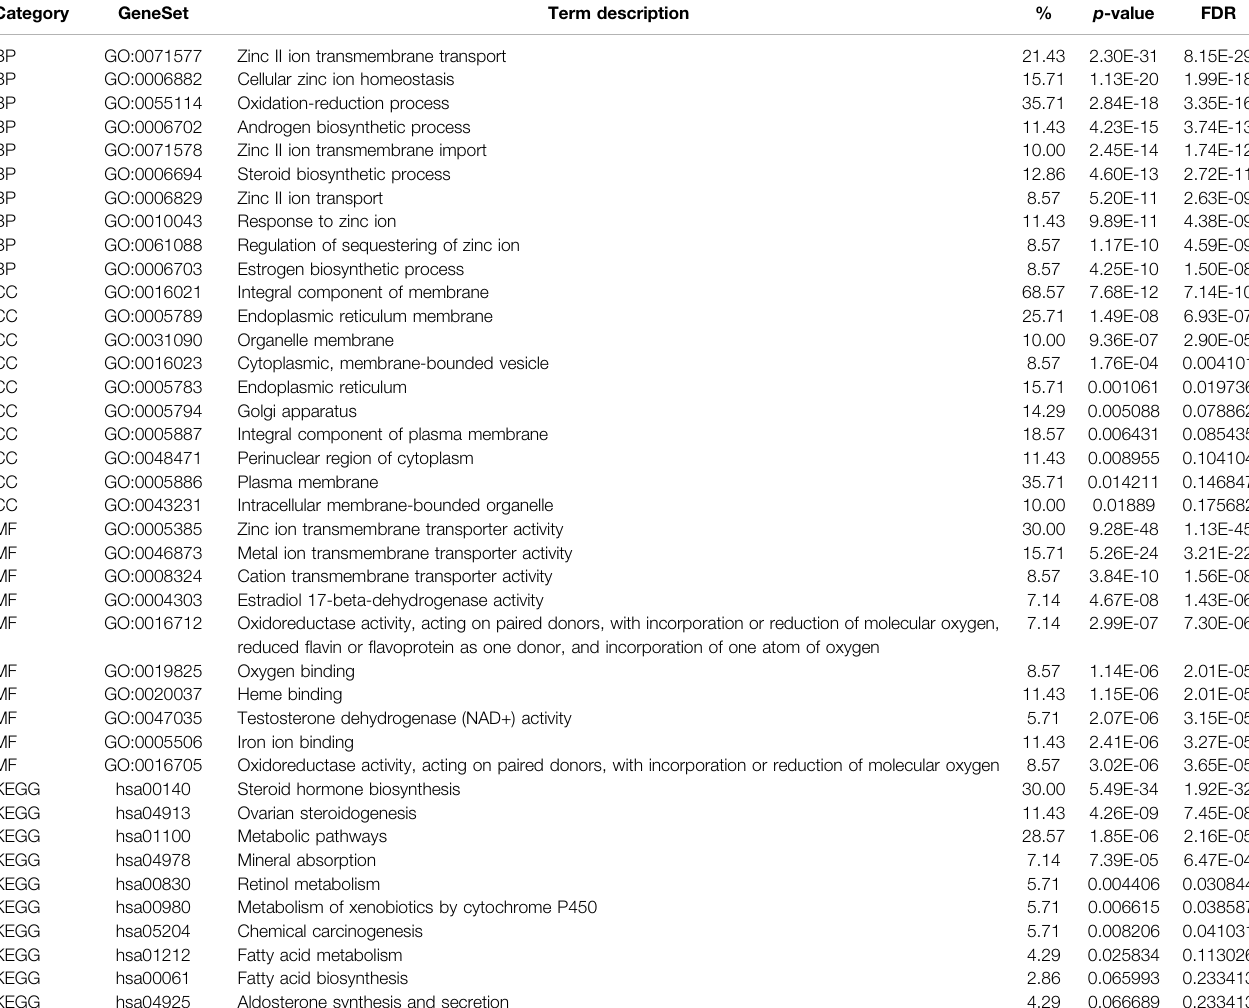
TABLE 1 | Top 10 GO and KEGG functional enrichment of SLC39A family highly related genes in pan-cancer derived from STRING, GENEMAIN, and DAVID datasets.